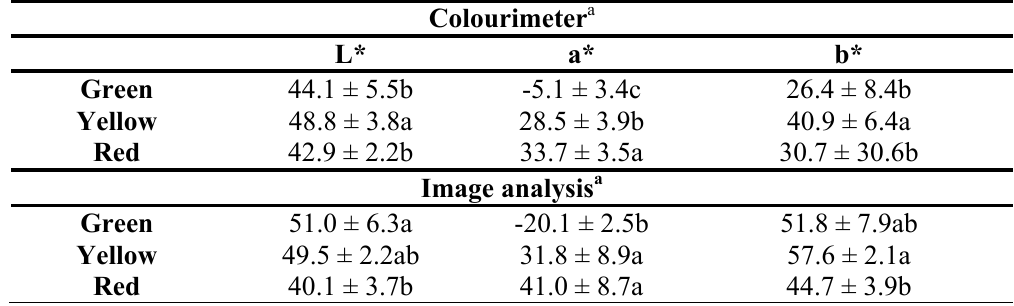
Table 1. Colour indices of green, yellow and red Solanum indicum L. berries.